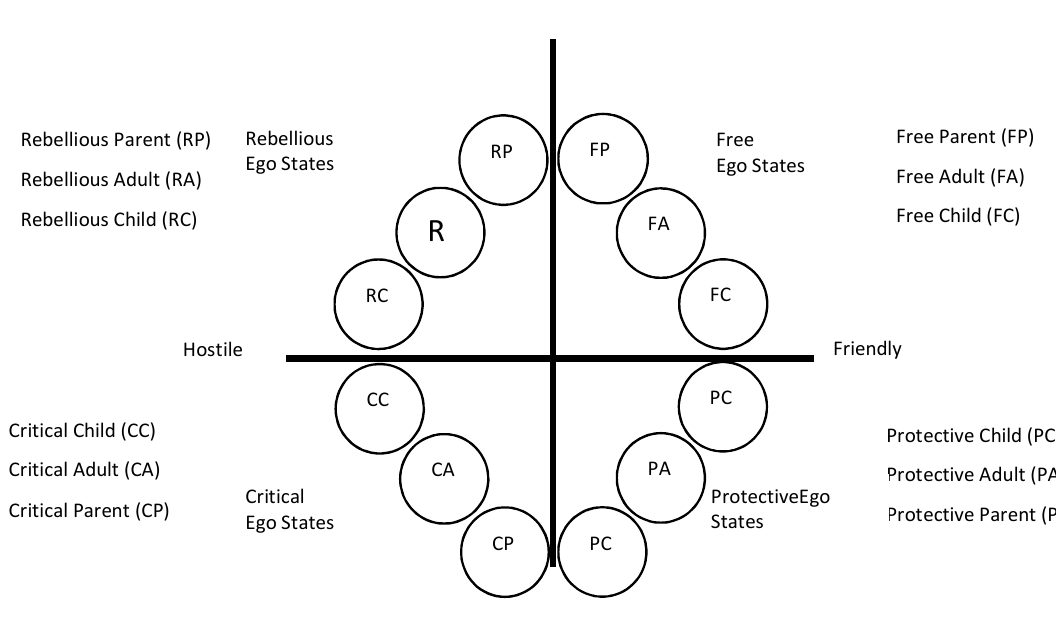
Figure 1: The 12 Ego States in the